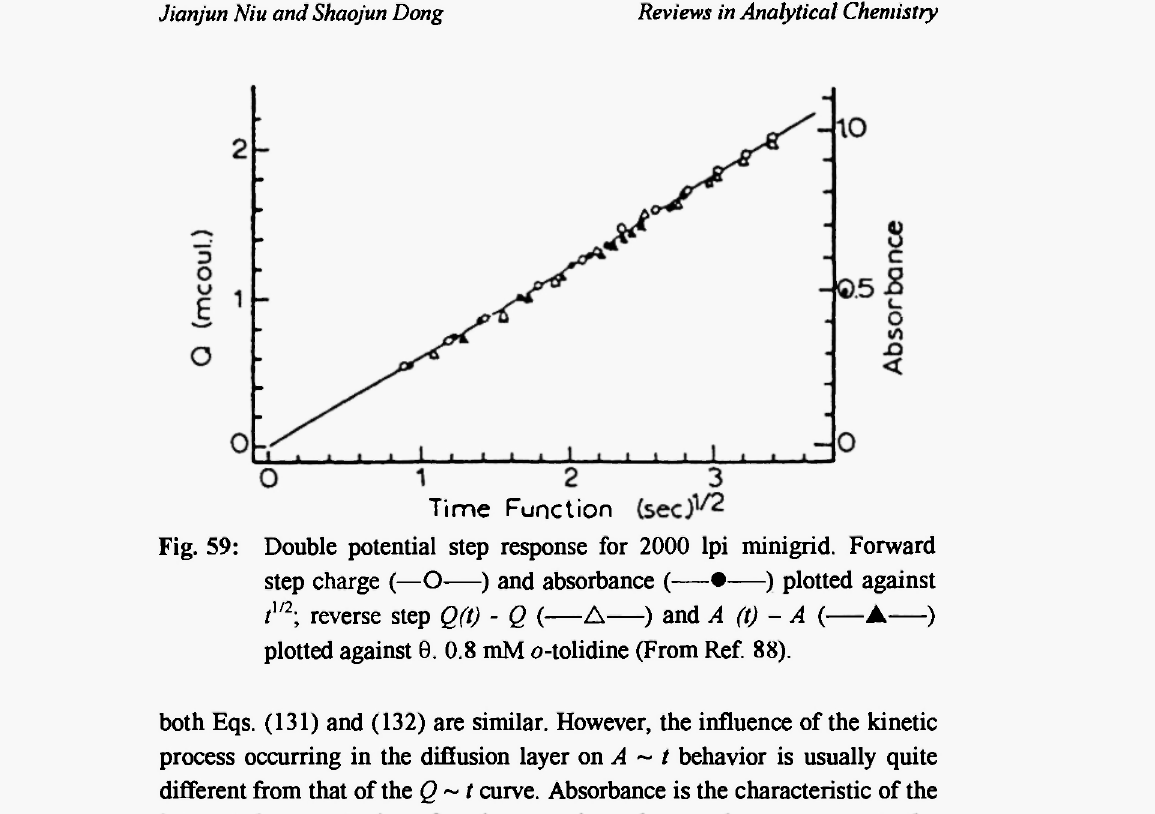
Time Function Fig. 59: Double potential step response for 2000 lpi minigrid. Forward step charge (—Ο ) and absorbance ( · ) plotted against f 1/2 ; reverse step Q(t) - Q ( Δ ) and A (t) - A ( • ) plotted against Θ. 0.8 mM o-tolidine (From Ref.